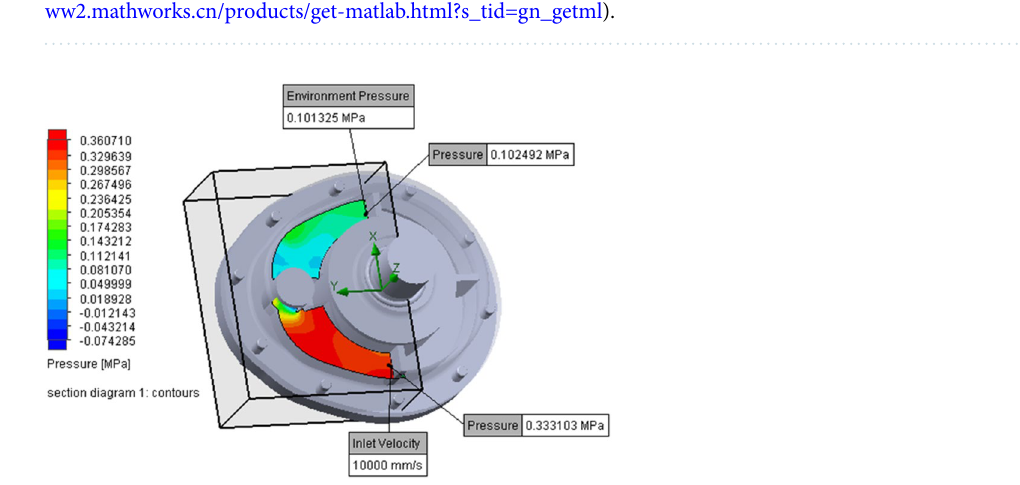
Figure 8. The rate of change of the length OP and its derivative when setting 𝛿 0 to 𝜋 ∕ 9 . (Matlab2019a. https://